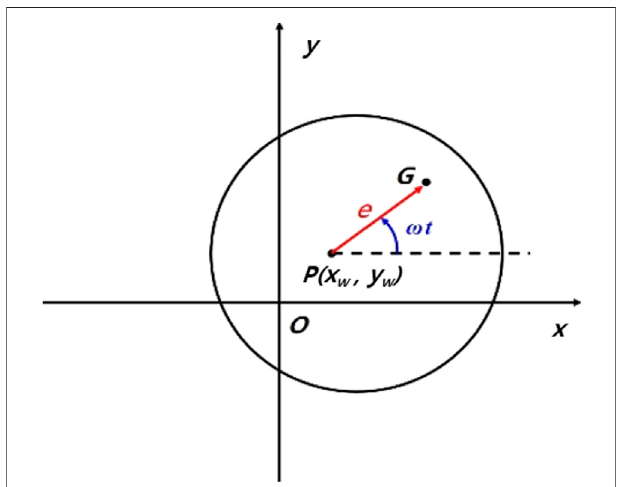
FIGURE 4 | Eccentricity of a rigid component.